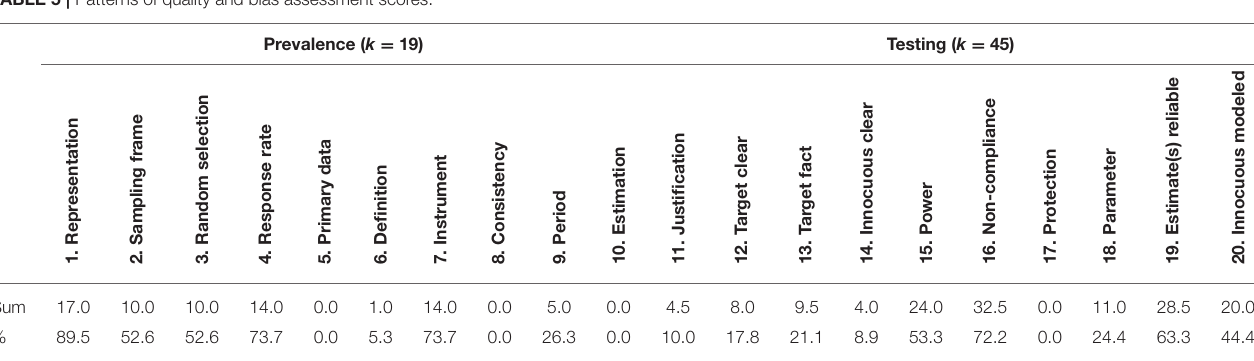
TABLE 5 | Patterns of quality and bias assessment